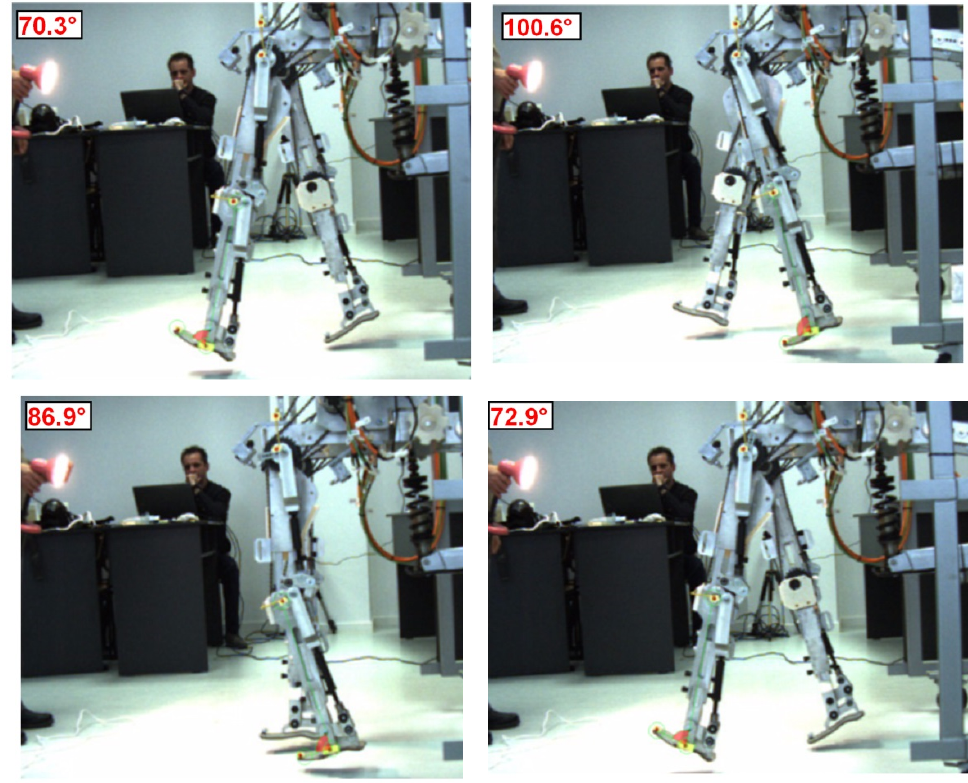
Figure 25. Snapshots during exoskeleton left knee joint without foot and ground contact.